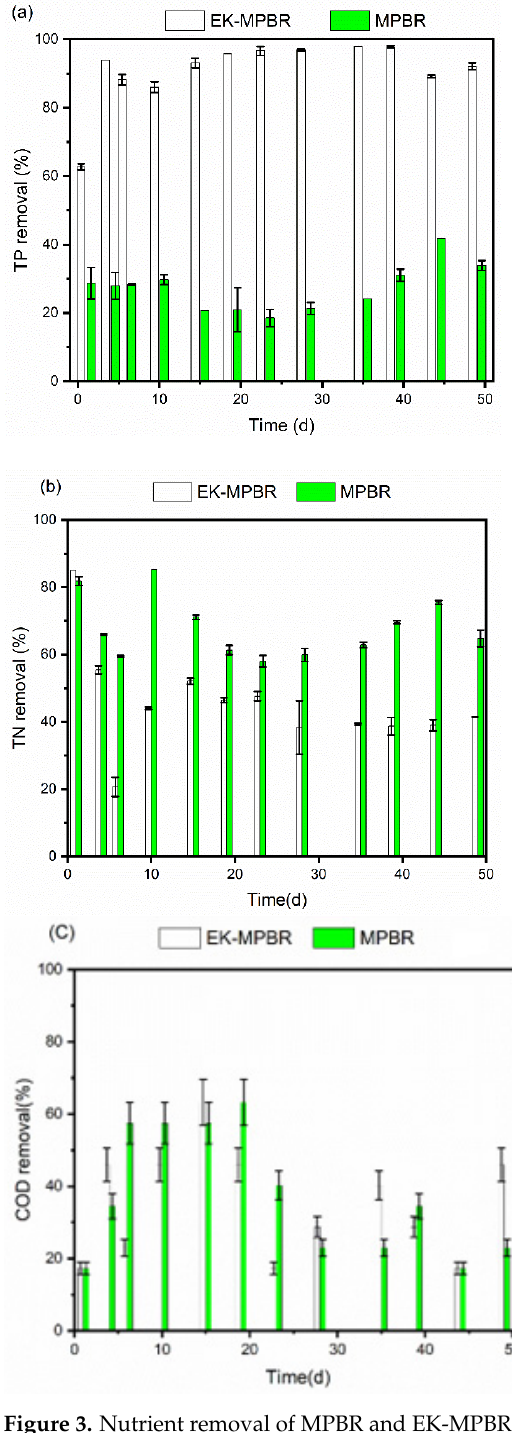
Figure 3. Nutrient removal of MPBR and EK-MPBR: ( a ) comparison of TP removal efficiency, ( b ) TN removal efficiency, and ( c ) COD removal efficiency.